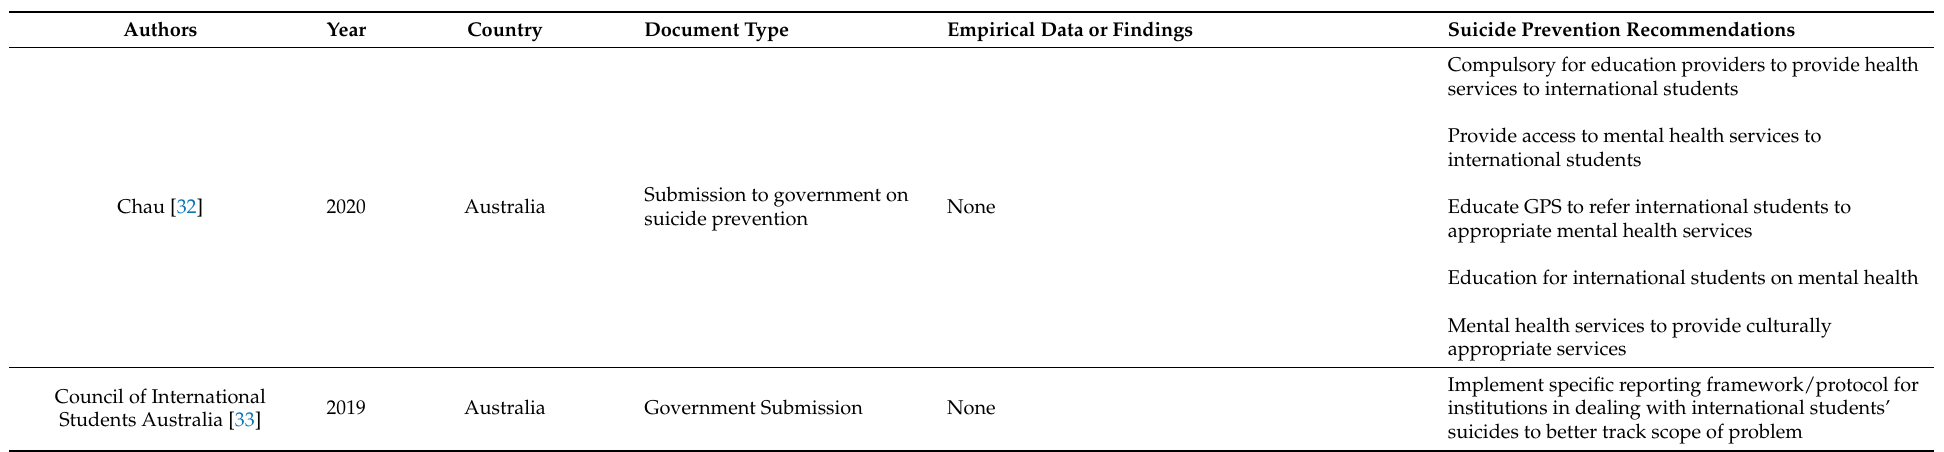
Table 2. Gray literature on Suicide Prevention among International